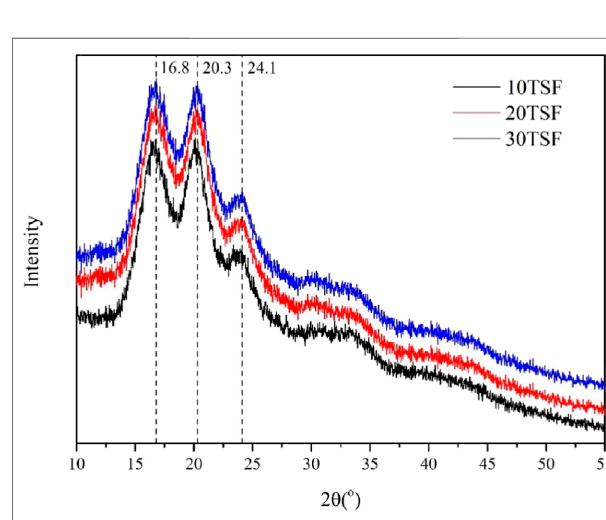
FIGURE 5 | XRD pattern of TSF nano fi ber mats after 10-, 20-, and 30- min physical